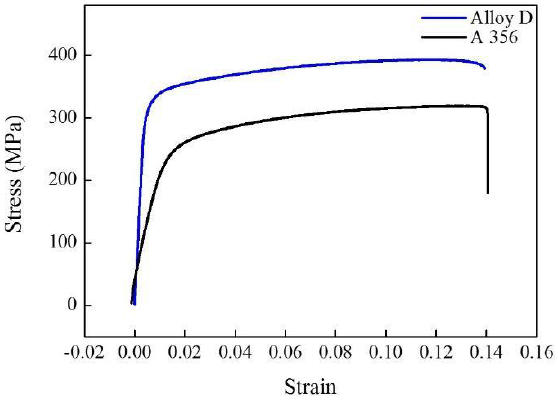
Figure 9. Engineering stress-strain curves of the samples taken from the steering knuckles cast with D alloy and A356 alloy. The tensile strength and elongation percentage for D alloy and A 356 alloy are 392.8 MPa and 12.3% and 318.7 MPa and 13.0%, respectively.